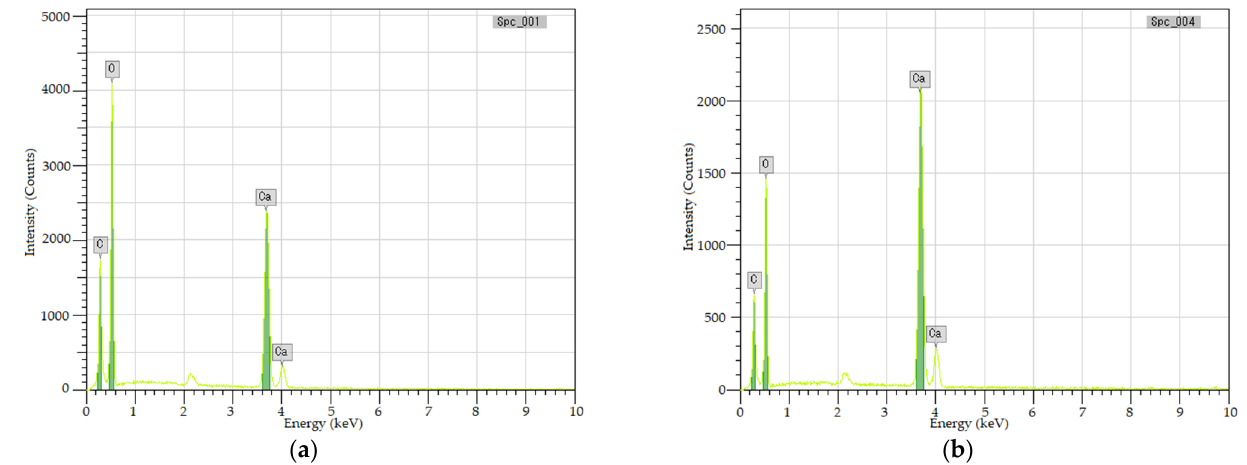
Table 3. Element content of the white sediments.